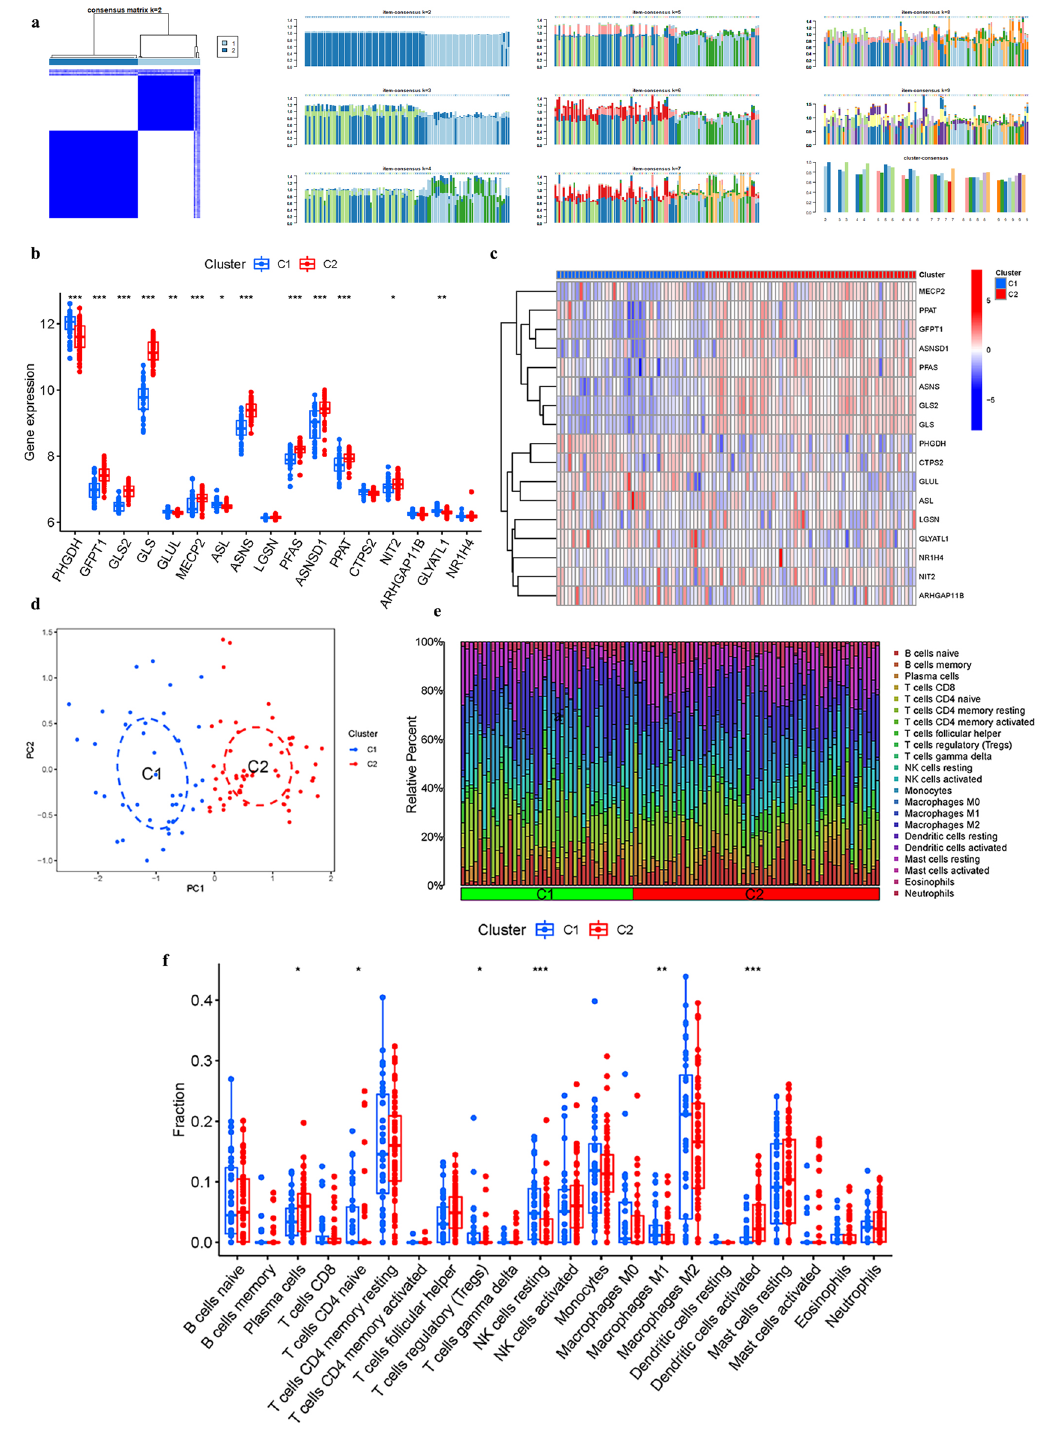
Figure 5. Cluster analysis. ( a ) Consensus clustering matrix. ( b , c ) Expression of the GlnMgs in different clusters. ( d ) PCA. ( e , f ) Immune cell infiltration of different